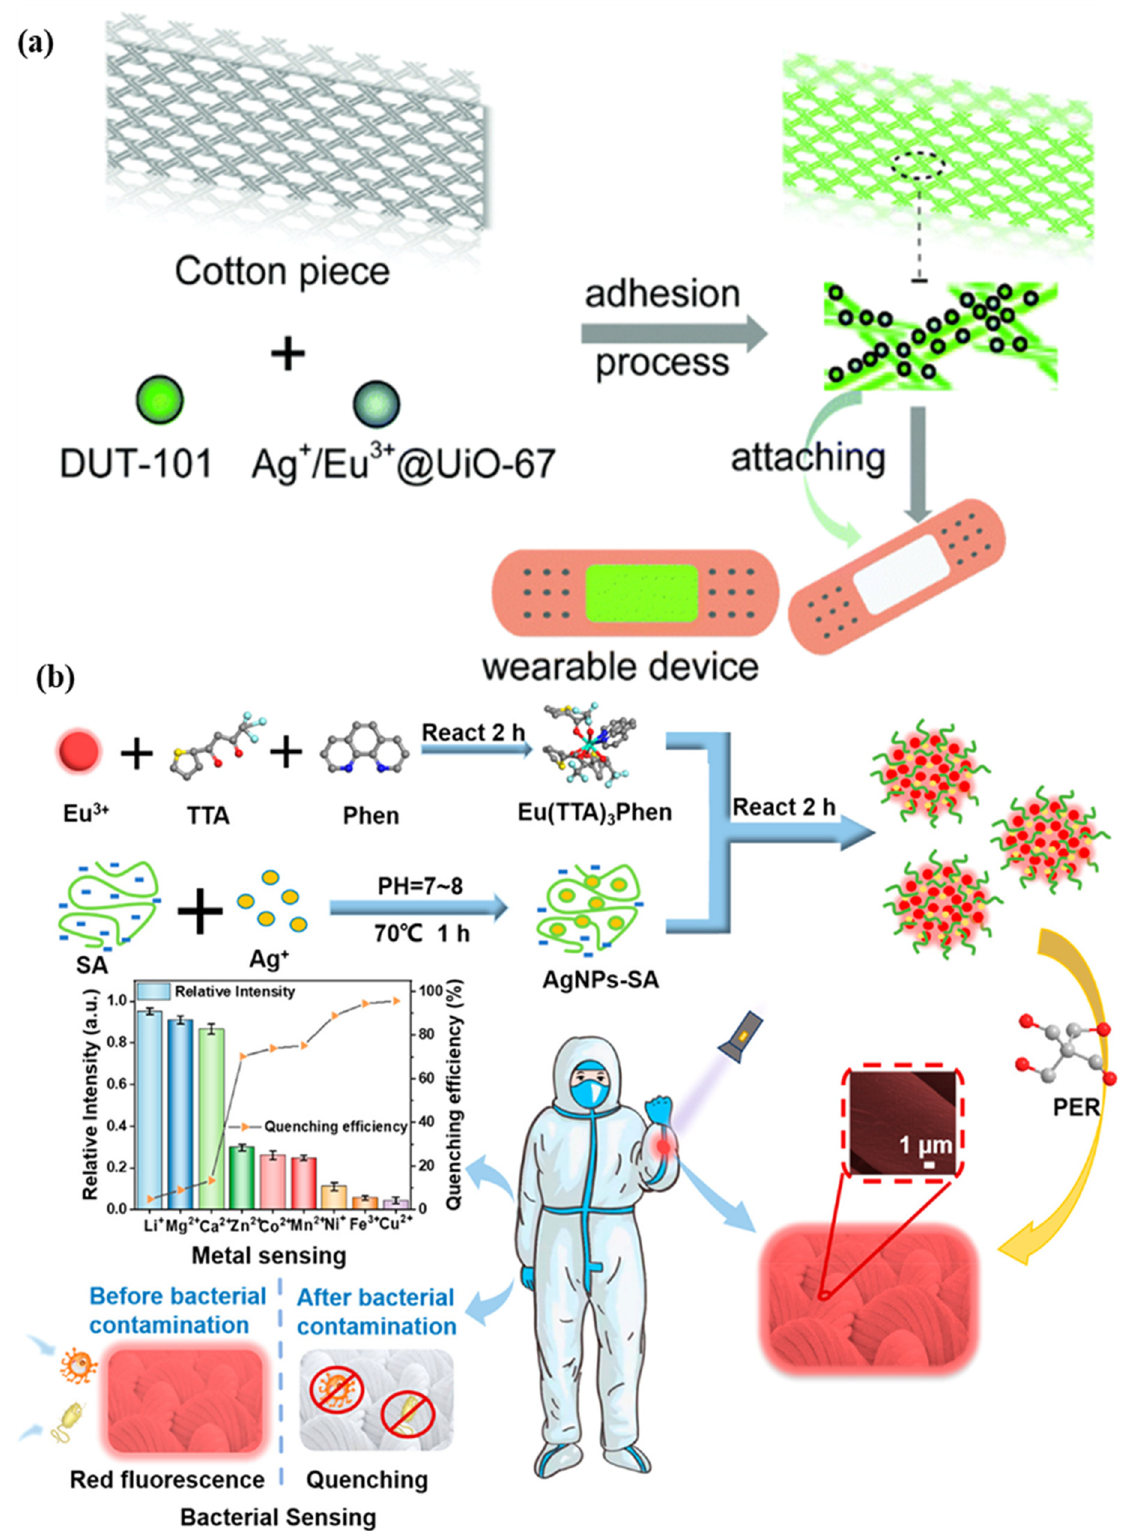
Figure 5. Illustration of ( a ) a metal–organic framework-based wearable sweat monitoring fluorescent device. Reprinted with permission from Journal of Materials Chemistry C, Copyright 2018, Royal Society of Chemistry [55]; ( b ) a fluorescent sensor for detecting Escherichia coli and Staphylococcus aureus pathogenic bacteria. Reprinted with permission from ACS Applied Nano Materials, Copyright 2012, American Chemical Society [29].